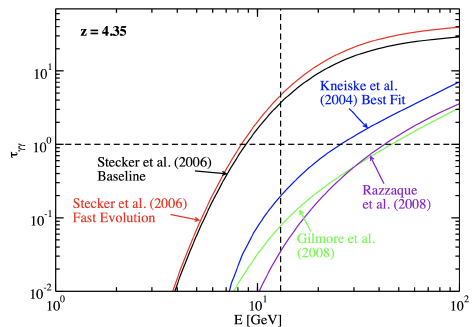
Figure 7. Opacity of the Universe to HE photons, emitted at a redshift of z = 4.35, due to their interaction with EBL photons as calculated using different models. The vertical dashed line marks a 13.2GeV photon detected from GRB080916C. Figure adapted from [119] (Reprinted with permission from